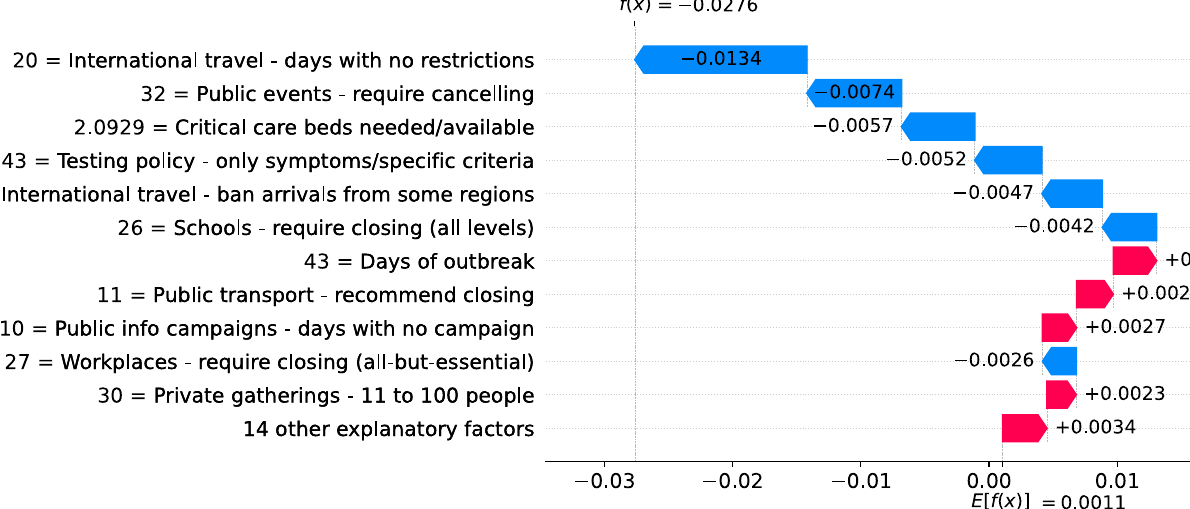
Fig 15. (Color online) factors driving acceleration in Netherlandson the 28 th day.